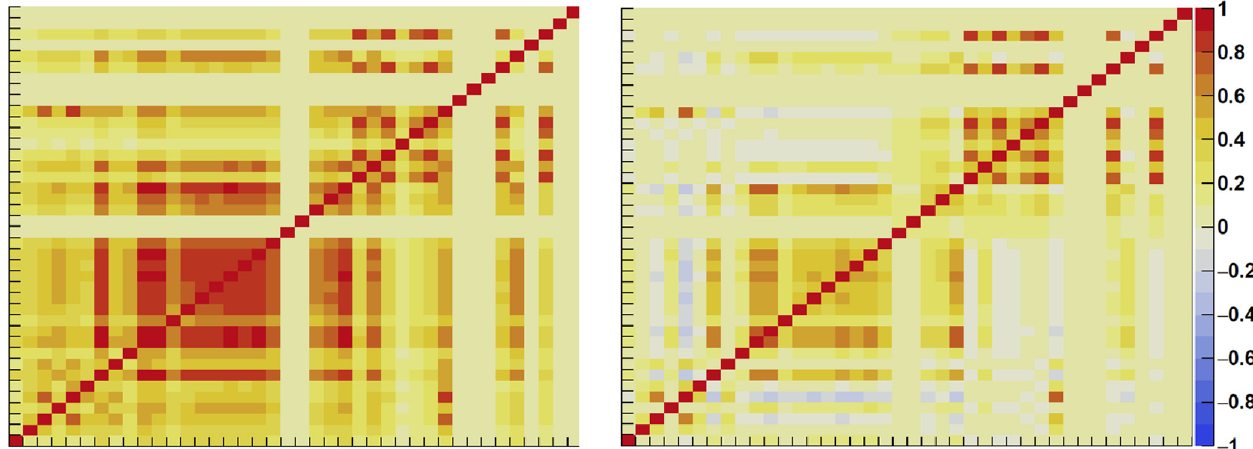
Fig. 9. The correlation matrix after the relative normalization when Exp.1 is the reference, on the left, and when Exp.2 is the reference, on the right. X and Y labels are identical to Figure 12